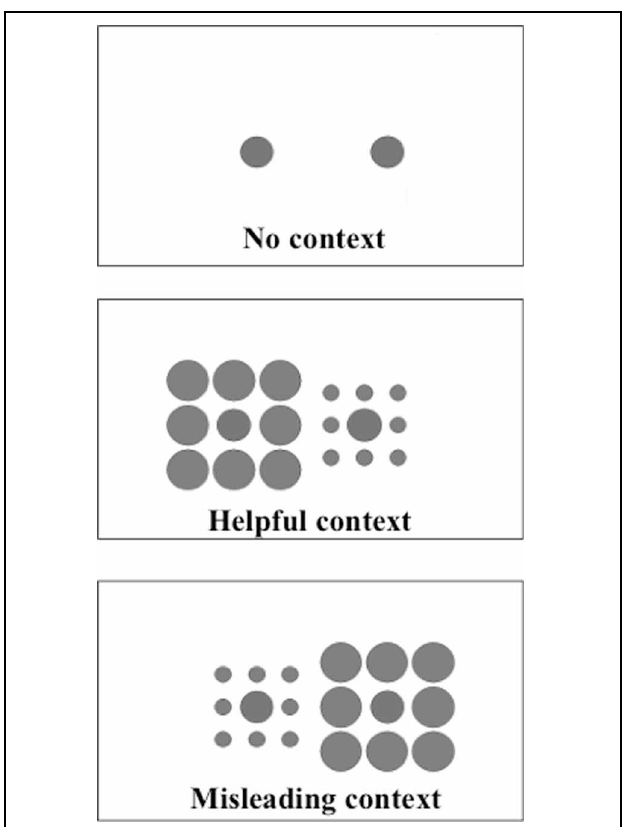
FIGURE 1 | Examples of the stimuli shown in each of the context conditions (the text was not present in the displays, only the circles). On each trial participants were presented with a display from one of the conditions, and were asked to indicate, via a keypress, which circle (or, in the misleading and helpful conditions, which inner circle) was largest, the one on the left or the one on the right. In each case shown here the inner circle on the right is 2% larger than that on the left. Figure reprinted, with permission by John Wiley and Sons, from Doherty et al.